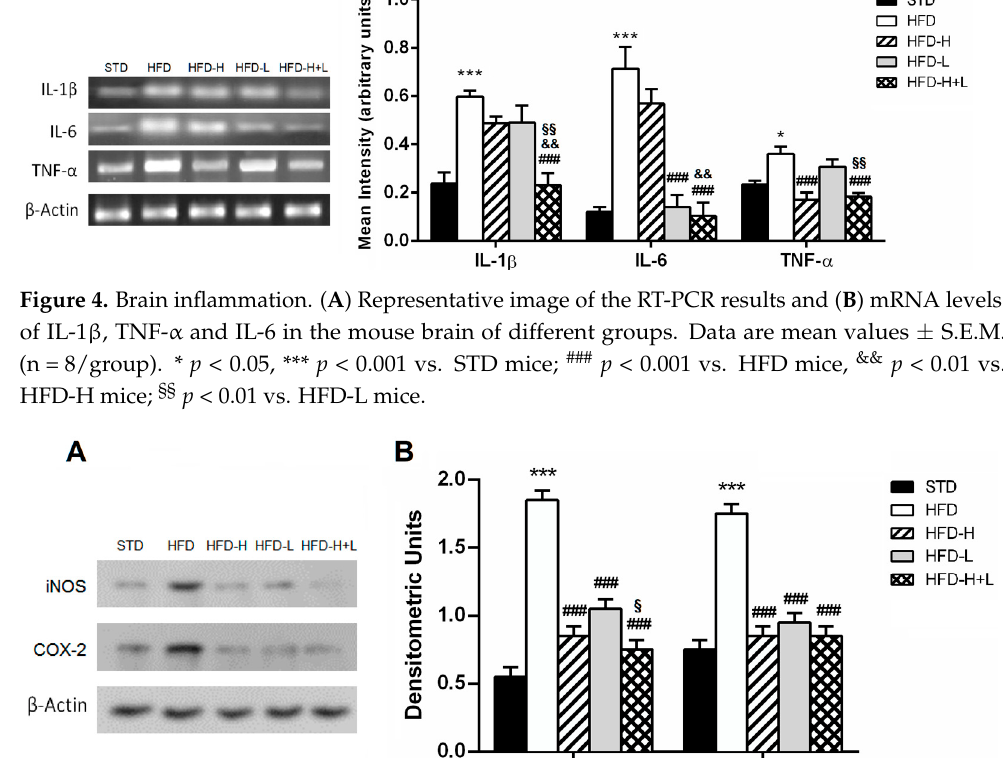
Figure 6. Brain oxidative stress. ( A ) Levels of ROS in the brain of STD, HFD, HFD-H, HFD-L and HFD-H + L mice. ( B ) Nitrite concentration in the brain of STD, HFD, HFD-H, HFD-L and HFD-H + L mice. Data are mean values ± S.E.M. (n = 8/group). *** p < 0.001 vs. STD mice; # p < 0.05, ### p < 0.001 vs. HFD mice; & p < 0.05 vs. HFD-H mice; § p < 0.05 vs. HFD-L mice. 2.6. Expression of Genes Involved in AD Using a Mouse Alzheimer’s Disease RT 2 Profiler PCR Array we analyzed expression changes of genes involved in the onset, development and progression of Alzheimer’s dis- ease in the different groups of animals. Among them, there are genes that contribute to amyloid beta-peptide (A β ) generation, clearance and degradation but also genes related to neuronal toxicity. The list of genes is shown in Table S1. We focused on the gene ex- pression levels that were affected more than two-fold among the analyzed groups. The results showed that in the HFD brains, various genes involved in the processing of Ami- loid β Precusor (APP) and TAU ( Aplp1 , Aplp2 , App , Apba3 , Apbb2 , Apoe , Ckk5 , Clu , Ctsl ,